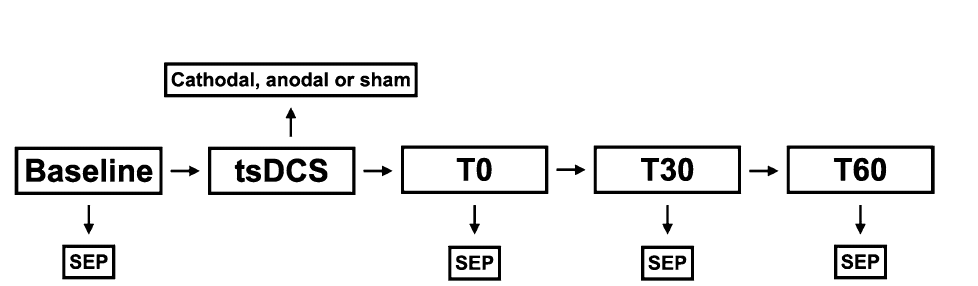
Table 1. Clinical characteristics of volunteers. Data given in mean ± SD.